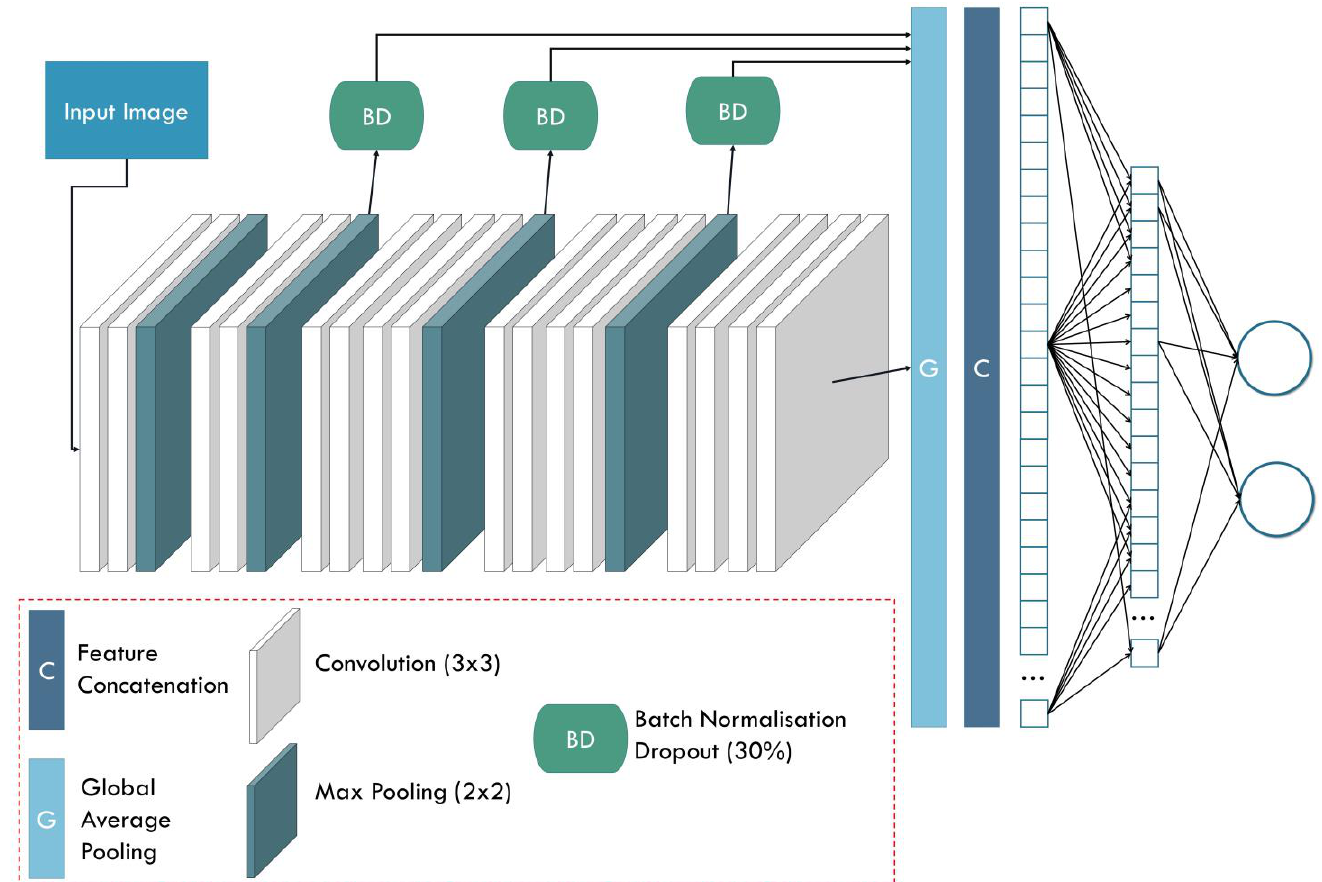
Figure 1. Structure of the FF-VGG19 network. Table 2. DL networks employed in the present study.